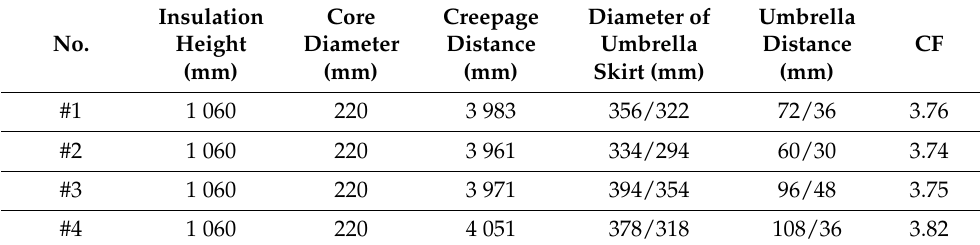
Table 5. Structure parameters.